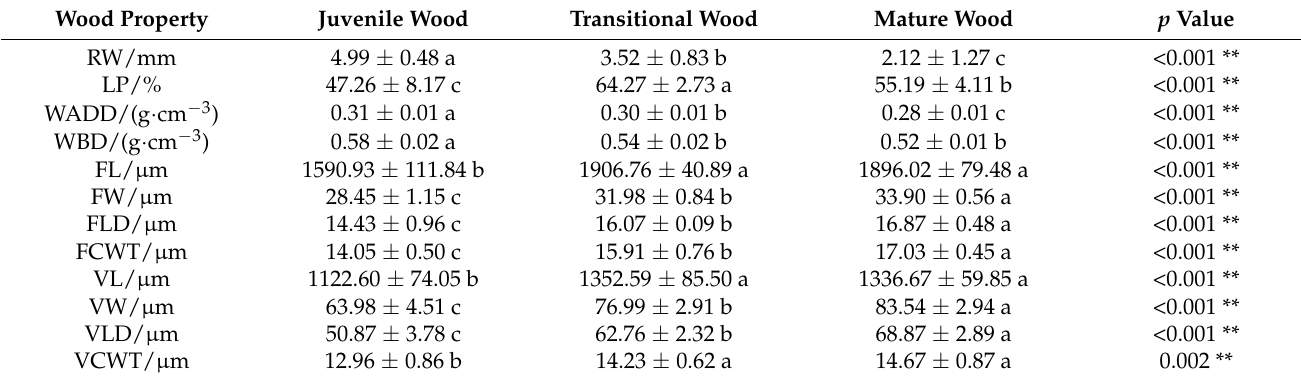
Figure 11. The determination coefficient ( R 2 ) of demarcation of juvenile wood, transition wood and mature wood in S. superba according to the optimal segmentation model. RW: ring width, WADD: wood air-dry density, WBD: wood basic density, FL: fiber length, FW: fiber width, FLD: fiber lumen diameter, FCWT: fiber cell wall thickness, VL: vessel length, VW: vessel width, VLD: vessel lumen diameter, VCWT: vessel cell wall thickness, AI: aggregative indicator. Table 6. Descriptive statistics for the juvenile wood, transition wood and mature wood of S. superba. Wood Property Juvenile